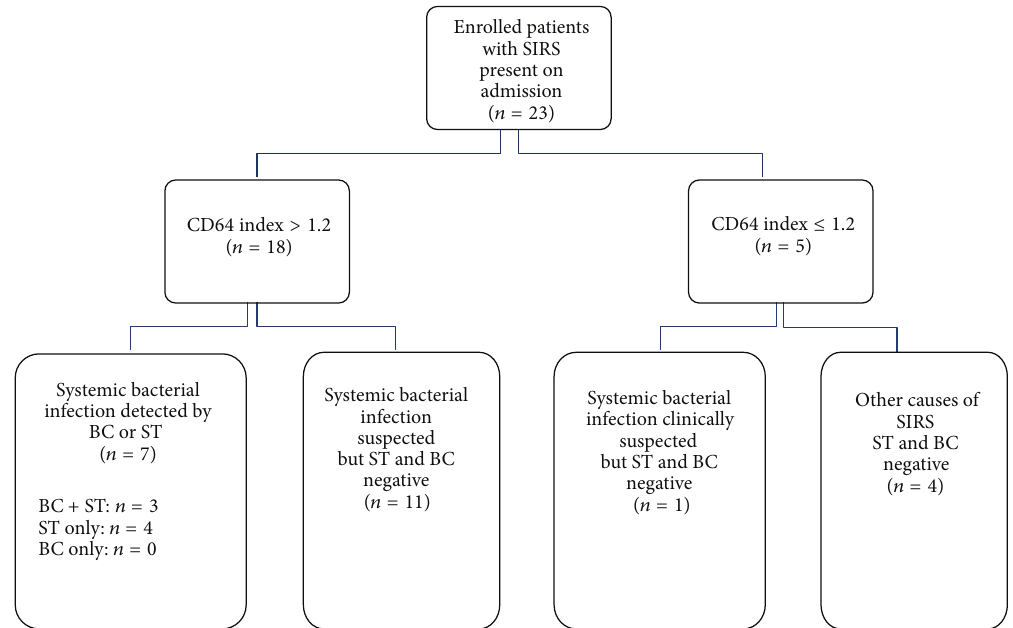
Figure 1: Flow diagram of patients enrolled in the study and results from CD64 index, BC, and ST (SIRS = systemic inflammatory response syndrome, ST = SepsiTest, and BC = blood culture).